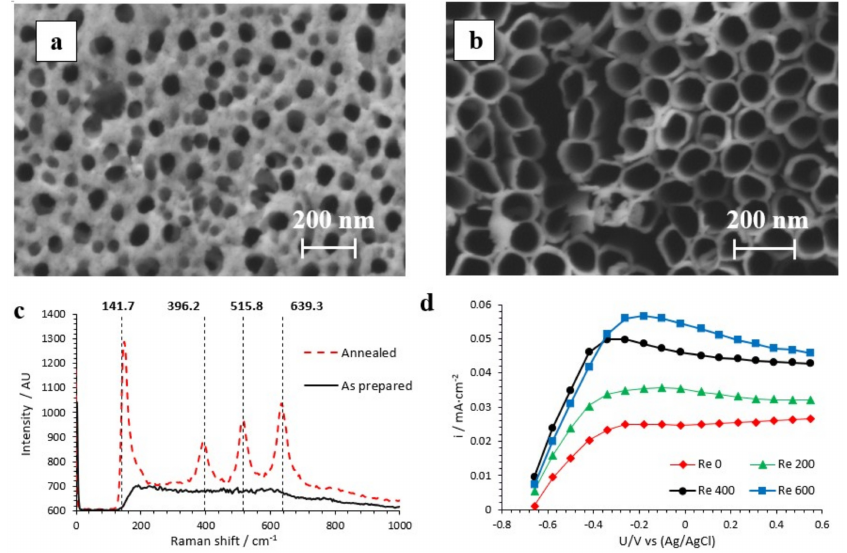
Figure 1. Field emission scanning electron microscopy (FE-SEM) images of the top view of the TiO 2 nanotubes anodized at ( a ) Re = 0 and ( b ) Re = 600. ( c ) Raman confocal laser spectra of the as-prepared and annealed samples anodized at Re = 600 (at 450 ◦ C for 1 h). ( d ) Maximum photocurrent densities versus potential curves of the samples anodized at Re = 0, 200, 400, and 600 (lengths = 3.7, 5.0, 5.4, and 6.1 µ m, respectively) under AM 1.5